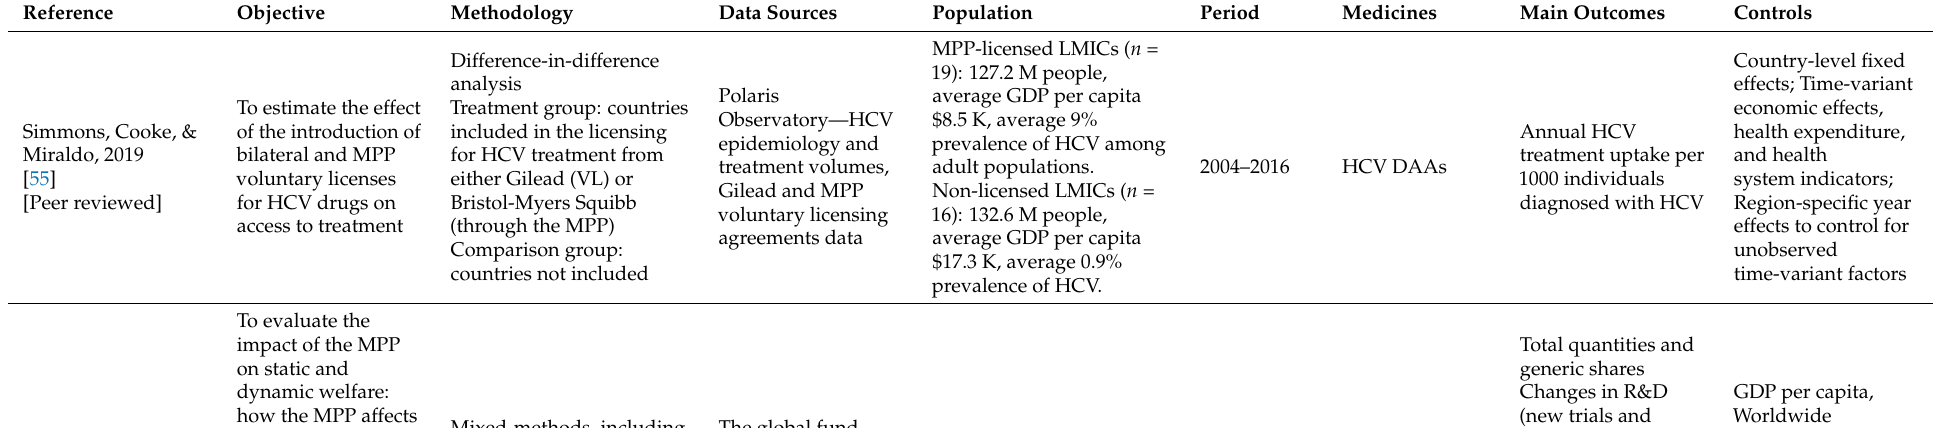
Table 2. Summary of Study